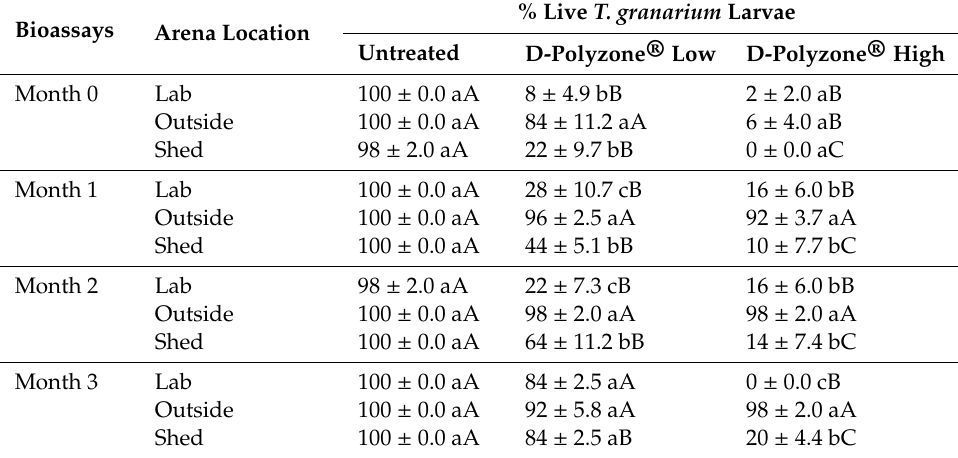
Table 2. Percentage of live Trogoderma granarium larvae (means ± SE) five days after being exposed on untreated arenas or arenas treated with low and high rates of deltamethrin (D) Polyzone ® . Arenas were held either in the laboratory, in an outside area, or inside a shed. Bioassays were conducted 1 day after treatment (month 0) and at 1, 2, and 3 months